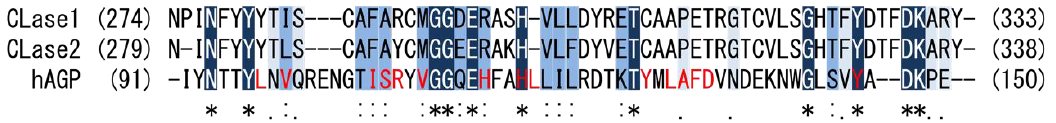
Figure A4. Luminescence intensity of Cypridina luciferin in the presence of a recombinant CLase from C. noctiluca with or without CPZ under various pH buffer conditions: the ratios indicate the molar ratio of CPZ to 6 pmol of Cypridina luciferin; without CPZ represents in the presence of only 6 pmol of Cypridina luciferin. The bars represent the mean values ± SD for n = 3.